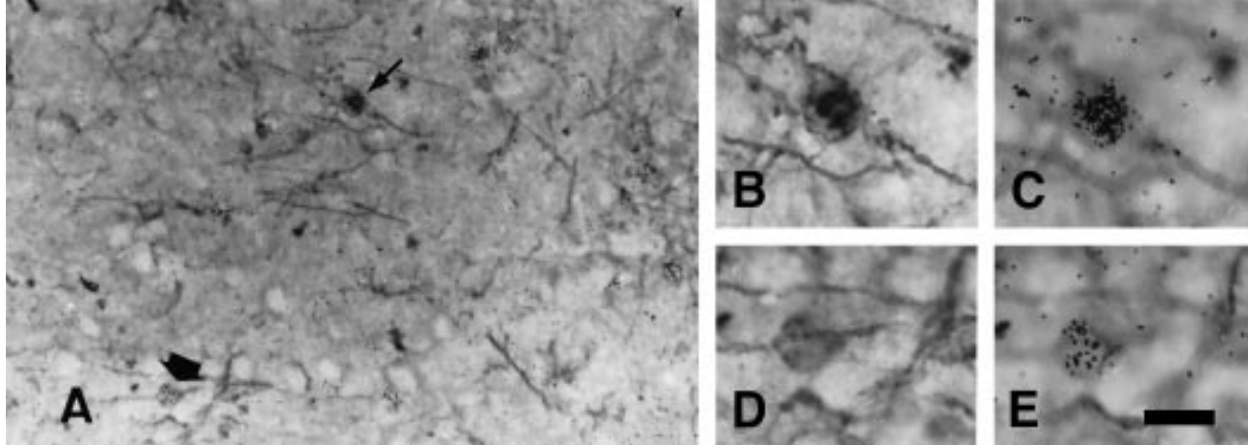
Figure 4 - Differentiation of oligodendroglia in the rostral brain stem. Photomicrographs of a coronal section passing through the midbrain tegmentum in a P37 opossum that received a single intraperitoneal [ 3 H]-T injection (10 µCi/g body weight) at P25. After the immunoreaction with the anti-CNPase antibody, the sections were submitted to the radioautographic procedure. A, Low power view of a field showing many CNPase+ cells and nerve fibers. The arrows point to some of the CNPase+ oligodendrocytes that also show radioautographic silver grains, with the cells indicated by a thin and a thick arrow shown at higher magnifications in B/C and D/E, respectively. B and D, Focus on the CNPase reaction product; C and E, focus on the silver grains. Note that the oligodendrocyte in B/C has a large number of silver grains, suggesting that it has stopped proliferating soon after [ 3 H]-T uptake. On the other hand, the cell in D/E, with a smaller number of silver grains, may have passed through several cell cycles between [ 3 H]-T uptake and the onset of CNPase expression at P35-37. Magnification bar: A = 50 µm; B-E = 10